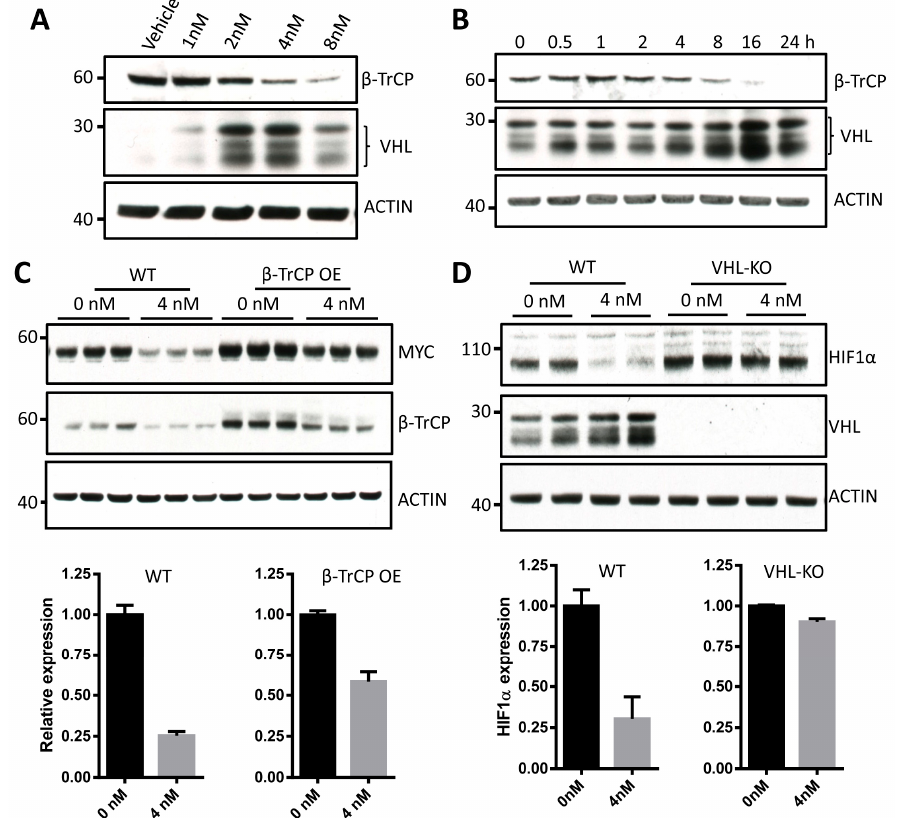
Figure 3. β -TrCP and VHL are involved in the degradation of MYC and HIF1 α induced by echinomycin, respectively. ( A ) Western blot analysis of β -TrCP and VHL proteins in H1944 lung adenocarcinoma cells treated with echinomycin at indicated concentrations for 24 h. ( B ) Time-dependent response of β -TrCP and VHL proteins in H1944 cells treated with 4 nM echinomycin at indicated time points. ( C ) Western blot and quantitative analysis of MYC in wild type H1944 cells and β -TrCP transduced H1944 cells treated with vehicle or 4 nM echinomycin for 24 h. ( D ) Western blot and quantitative analysis of HIF1 α in wild type H1944 cells and VHL deficient H1944 cells treated with vehicle or 4 nM echinomycin for 24 h. Experiments were repeated 2–3 times.